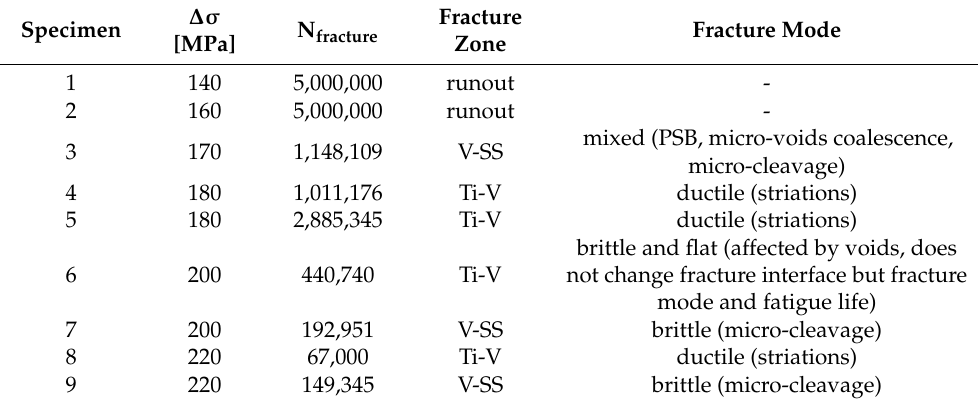
Table 9. Summary of fracture